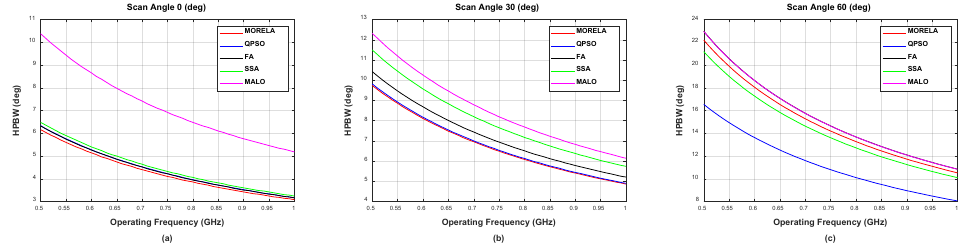
Figure 4. The HPBW performance of symmetric NUSLA in case for ( a ) θ 0 = 0°, ( b ) θ 0 = 30°, and ( c ) θ 0 = 60°.